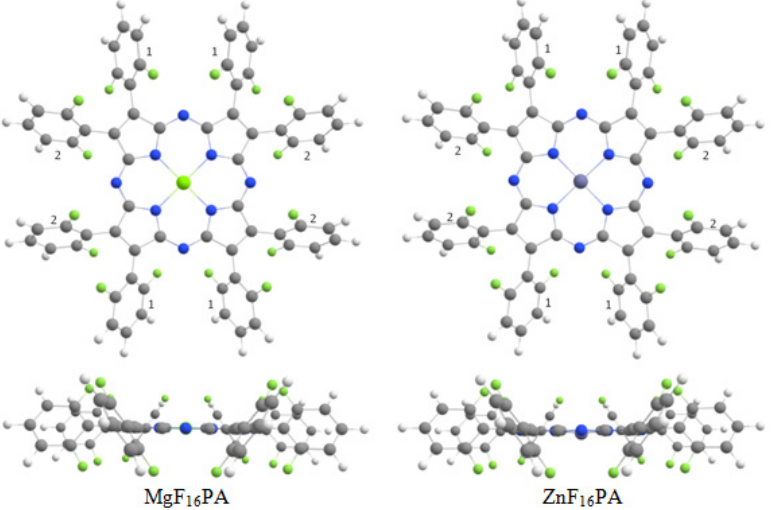
Figure 5. Structures of the complexes and types of phenyl rings, which are given according to the calculations.